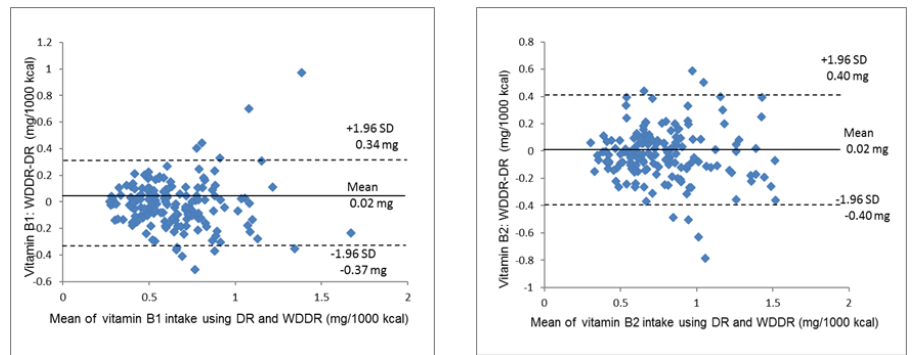
Figure 5. Bland–Altman plots for agreement between energy-adjusted intakes of nutrients (calcium, iron, vitamin A, vitamin E, vitamin B1 and vitamin B2) using the DR and WDDR for 163 women for